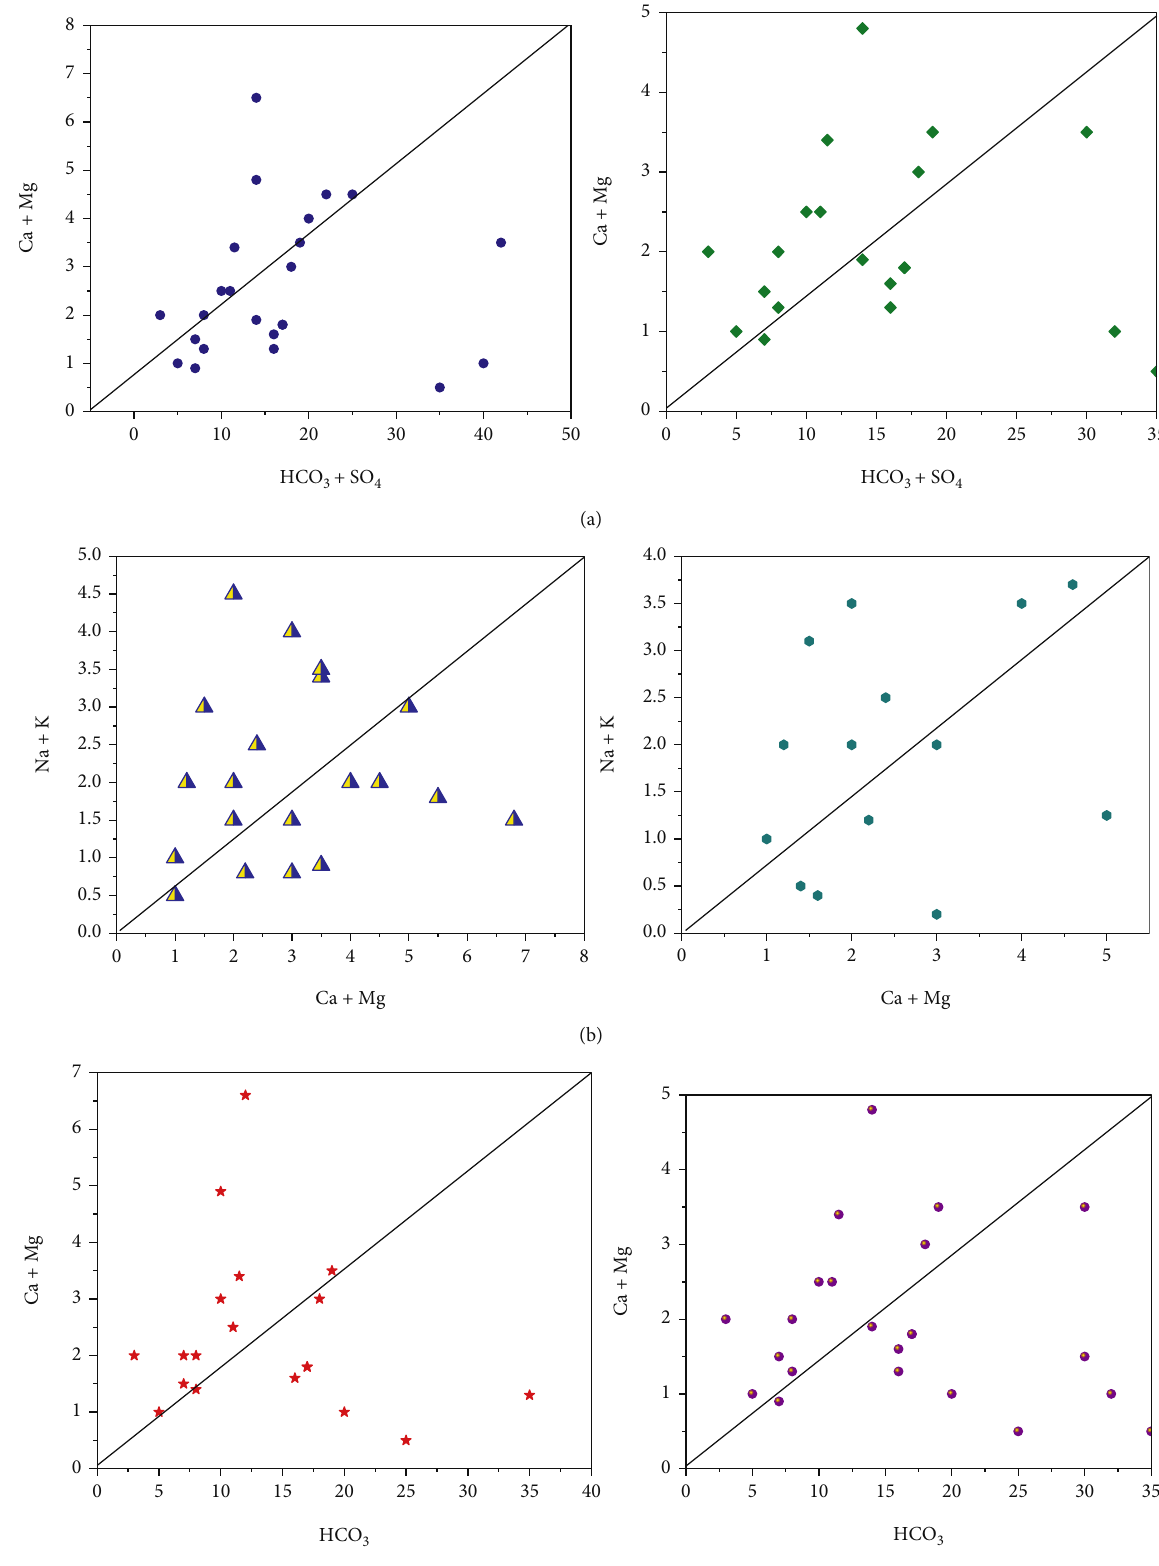
Figure 3: Scatter diagram. (a) HCO